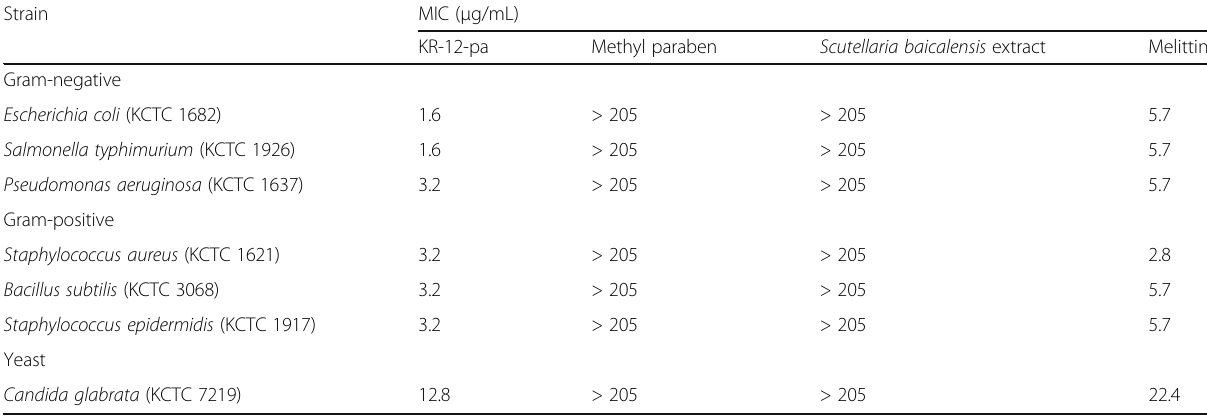
Table 3 Minimal inhibitory concentration (MIC) of KR-12-pa, methylparaben, Scutellaria baicalensis extract, and melittin